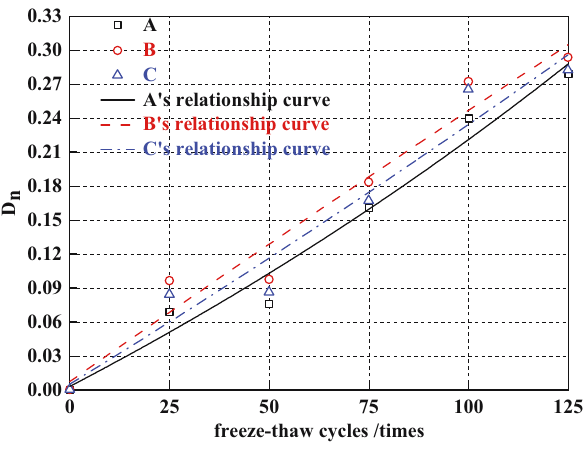
Figure 10: Relationship between D n and freeze – thaw cycles.